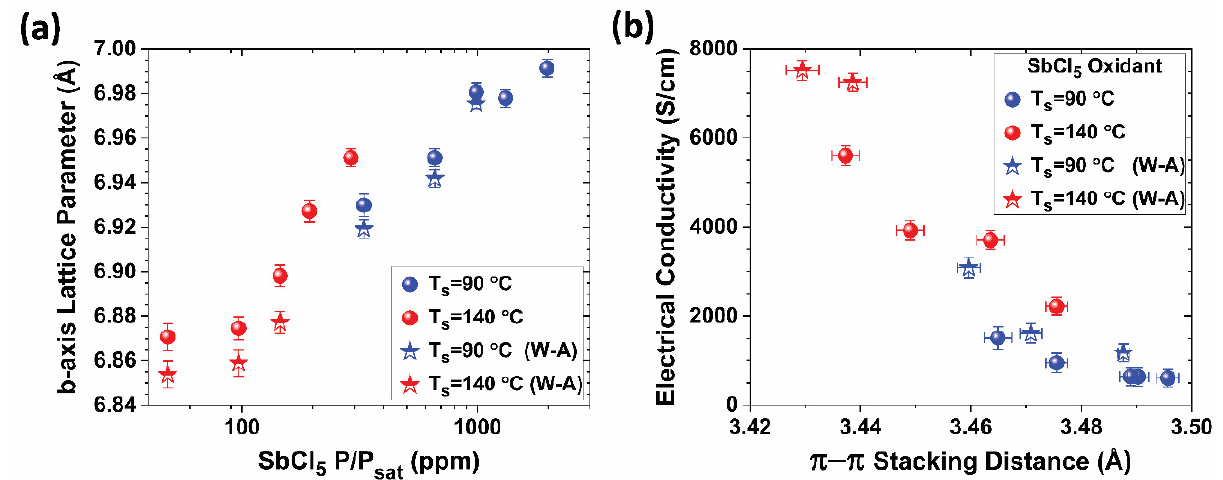
Figure 15. Influence of π‐π stacking on the electrical conductivity of the PEDOT polymer [18]. ( a ) Impact of the oxidant saturation ratio (OSR) on the b ‐ axis lattice parameter of as ‐ deposited PEDOT thin films at different growth temperatures with and without the use of water ‐ assisted (W ‐ A) growth in the oCVD method. ( b ) Electrical conductivity as a function of π‐π stacking distance in PEDOT thin films. ( a , b ) Reproduced with permission [18]. Copyright 2020, Wiley.